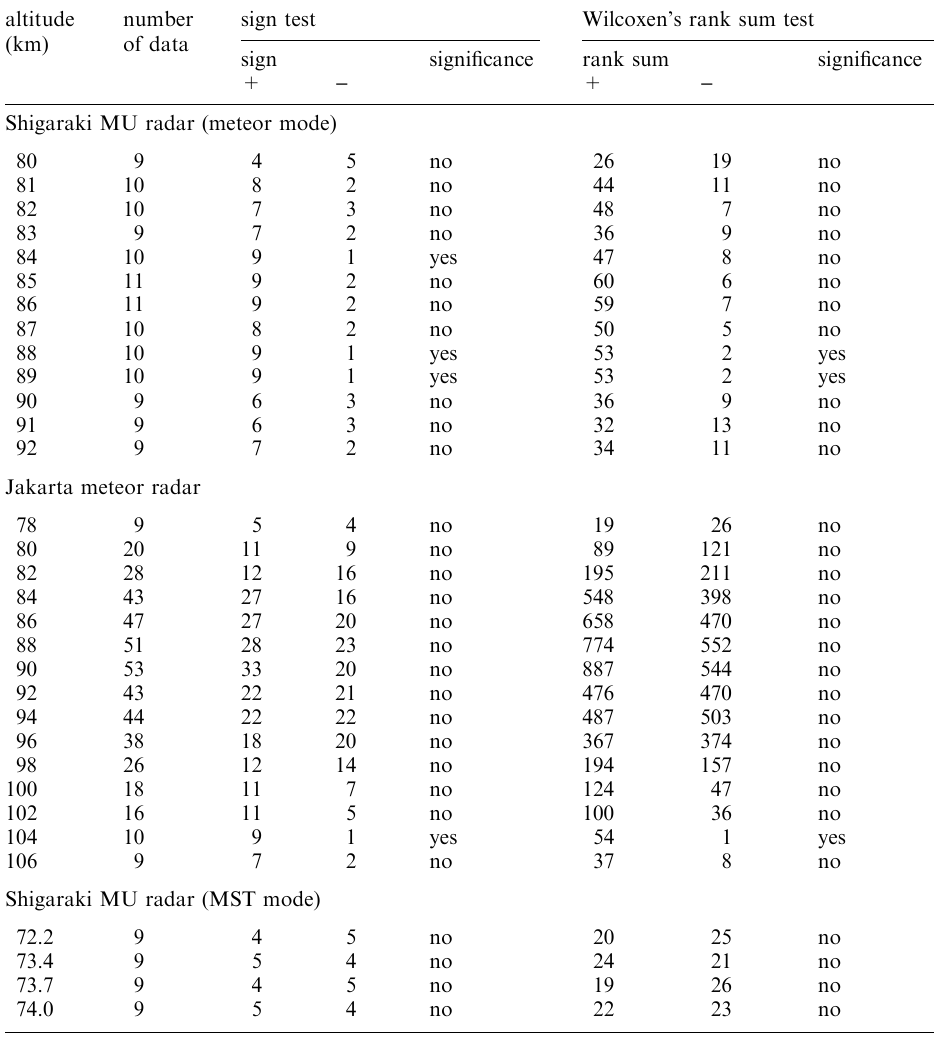
Table 3. Results of nonpara- metric statistical tests for the di(cid:128)erence of the wind speed derived by HRDI and radar observations; significance level is